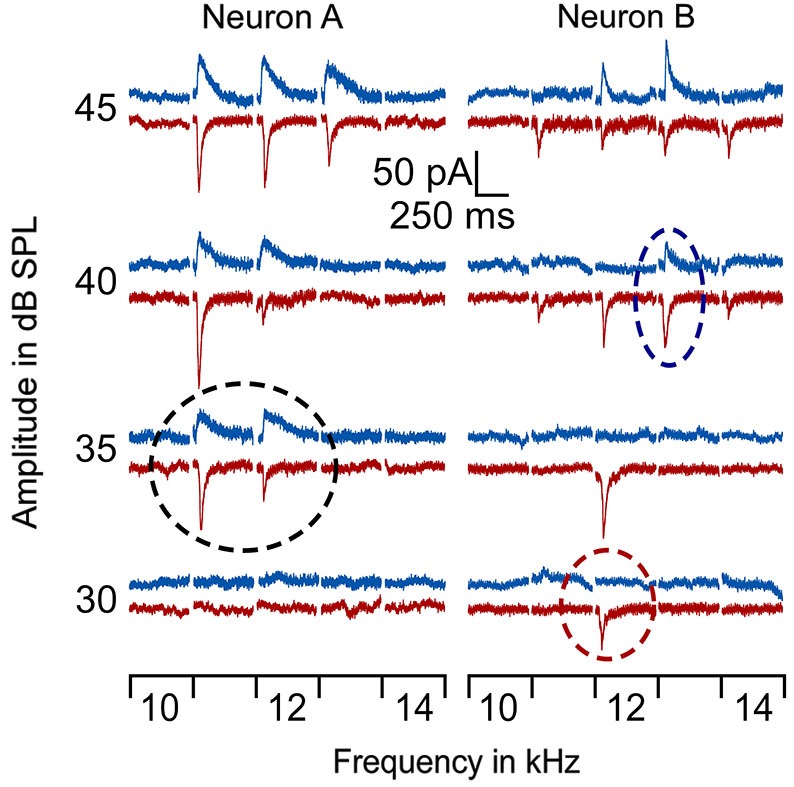
Examples of EPSCs and IPSCs of 2 AI neurons in response to tones around BF/MT. The BF/MT of EPSC and IPSC were identical in Neuron A (left) but not in Neuron B (right) as indicated by the dashed circles. Red lines represent EPSC and blue lines represent IPSC. The black circle shows the balanced EPSC and IPSC at MT (35 dB SPL) for neuron A. The red circle shows the MT of EPSC at 30 dB SPL and the blue circle, the MT of IPSC at 40 dB SPL.